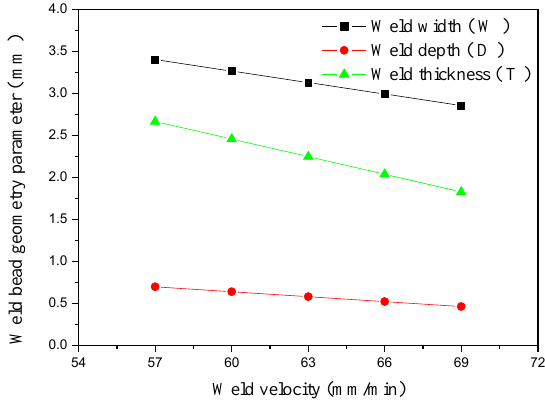
Figure 6. Influence of welding velocity on weld bead. (Welding peak current (I) = 120 A, d = 50%, P = 90°).